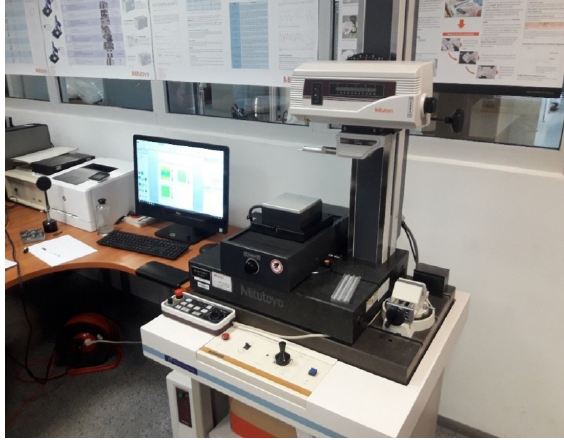
Figure 4. Mitutoyo profilografometer SURFTEST SV-3200.